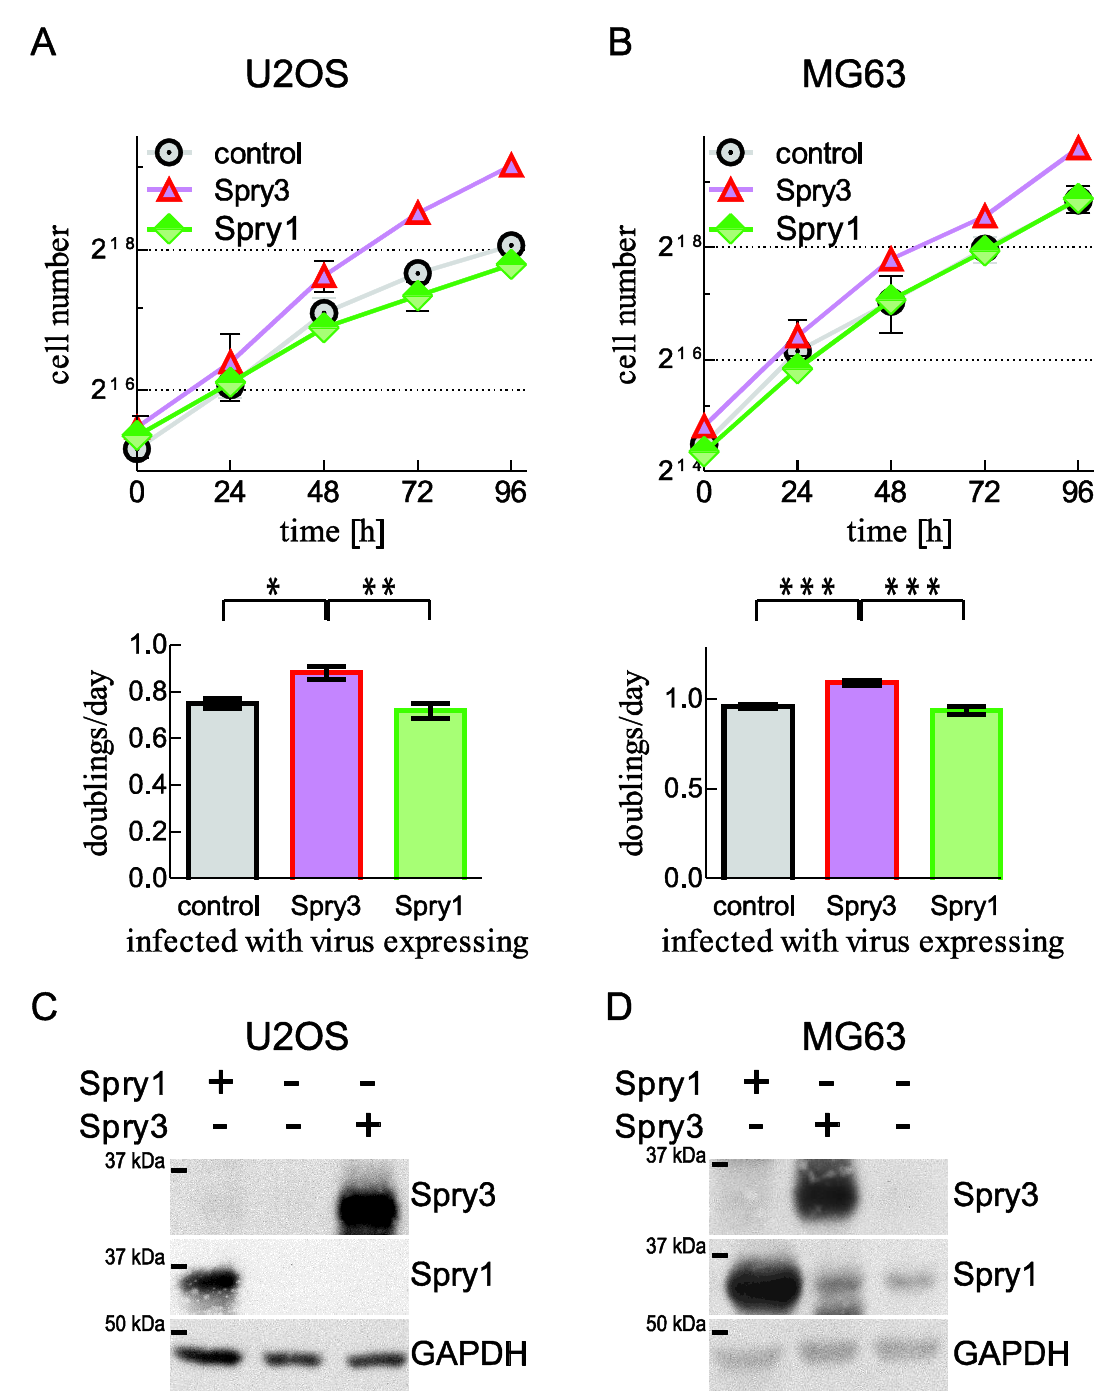
Figure 3. Influence of Spry3 and Spry1 expression on cell proliferation of osteosarcoma-derived cells. U2OS ( A ) and MG63 ( B ) cells infected with adenoviruses expressing Spry3, Spry1 or a control protein were analyzed. The number of cells were counted every 24 h for four days. A representative growth curve depicting the counted cell number of three replicates using a log2 scale is shown. Using GraphPad Prism 5.0 software (San Diego, CA, USA), doubling times of at least three independent growth curve analyses were calculated using exponential equation. The calculated values are presented as mean doublings per day ± SEM. Overexpressions of Spry1 and Spry3 in U2OS ( C ) and MG63 ( D ) were verified by immunoblotting using the indicated antibodies. *** p < 0.001, ** p < 0.01; * p < 0.05.